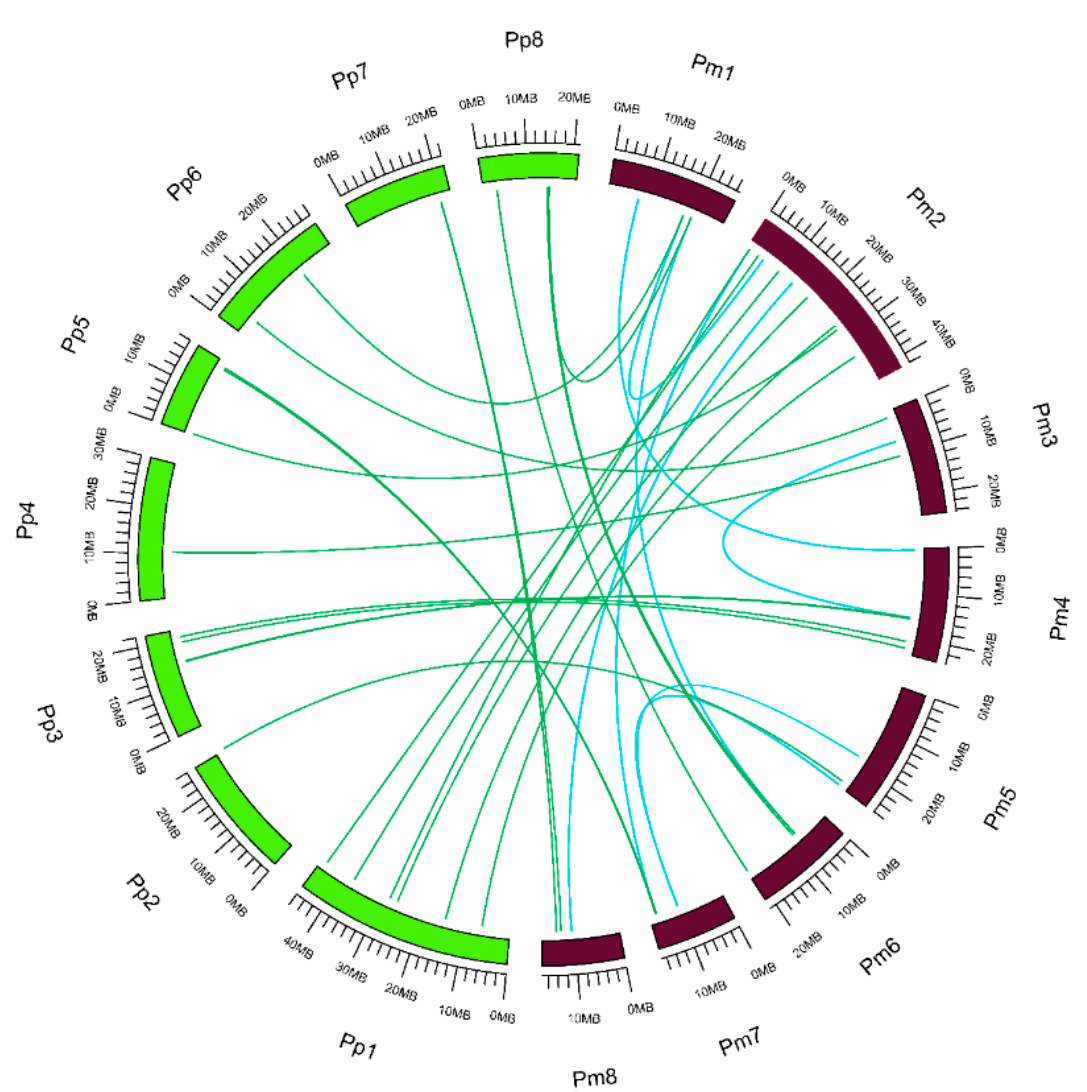
Figure 2. Syntenic relationships among UGTs in P. mume and P. persica . Chromosome are shown in the outer circle, with Pm1–8 and Pp1–8 indicated in brown and green, respectively. Genome-wide duplicated UGTs in P. mume are connected by blue lines. Genome-wide duplicated UGTs between P. mume and P. persica are connected by green lines.